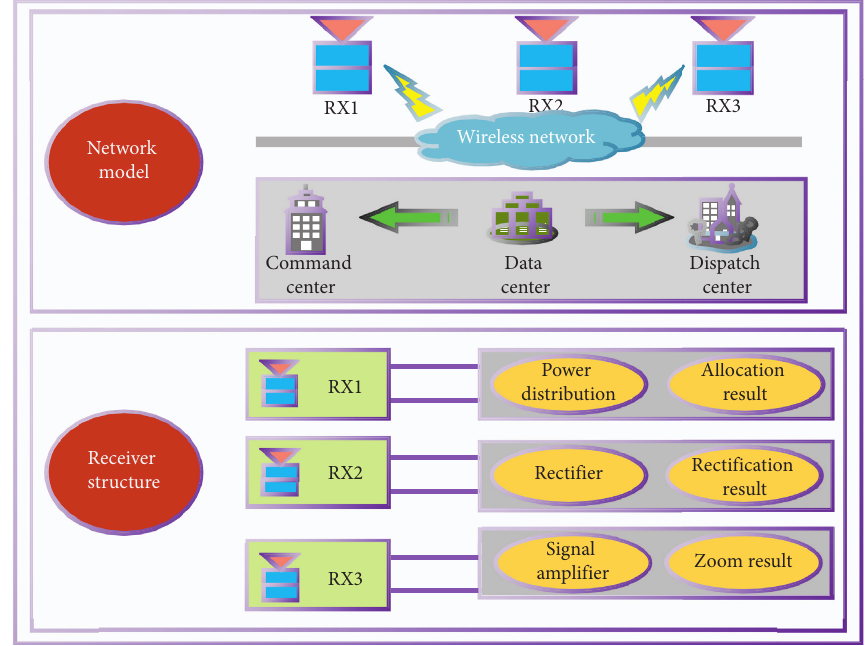
Figure 2: SWIPT network model and receiver